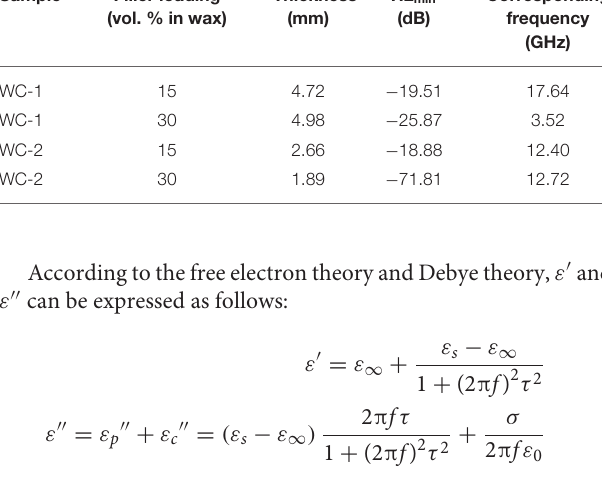
TABLE 1 | EA performance of WC-1 and WC-2.